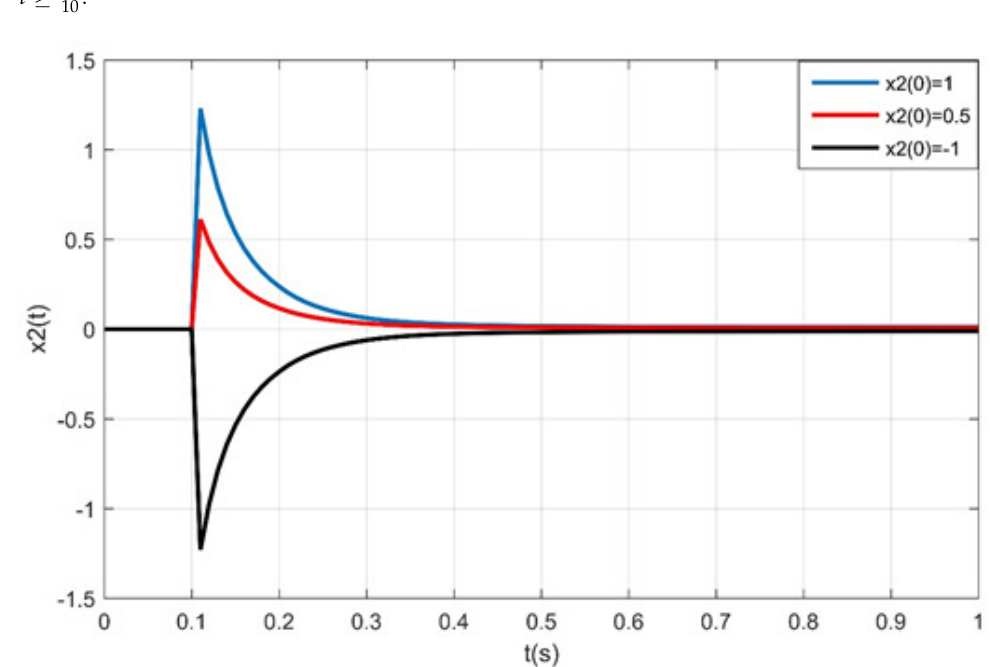
, ρ = 1 and different initial values when 5 10